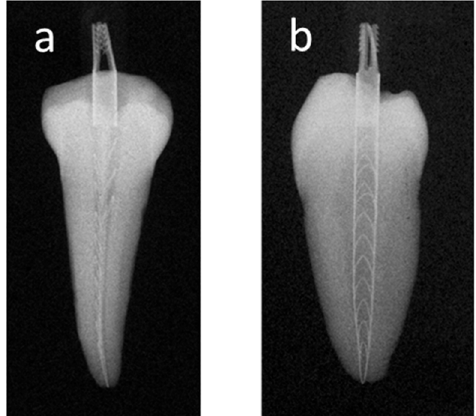
Figure 3. Adaptation of the self-adjusting file (SAF) to an oval canal. Radiographs of a mandibular premolar with an oval canal, with the SAF adapted to an oval canal. ( a ) Bucco-lingual projection. ( b ) Mesio-distal projection.